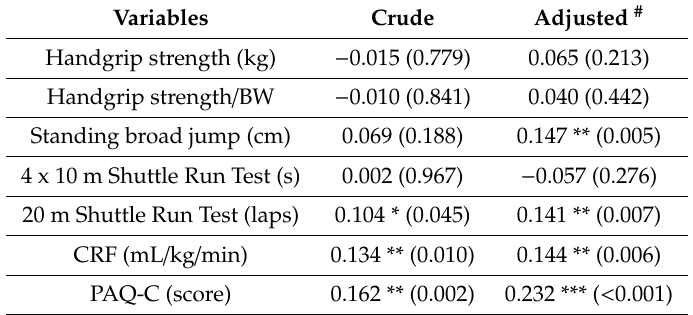
Table 2. Bivariate and partial correlations between KIDMED index score and di ff erent variables of the